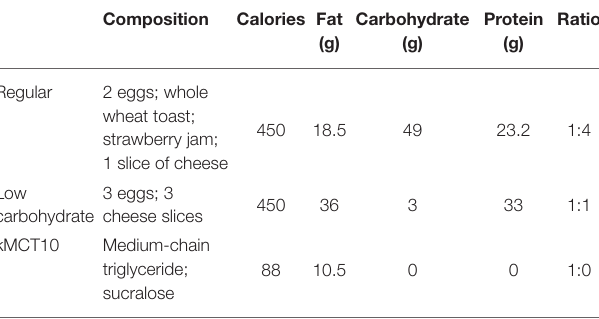
TABLE 2 | Meal and drink composition.